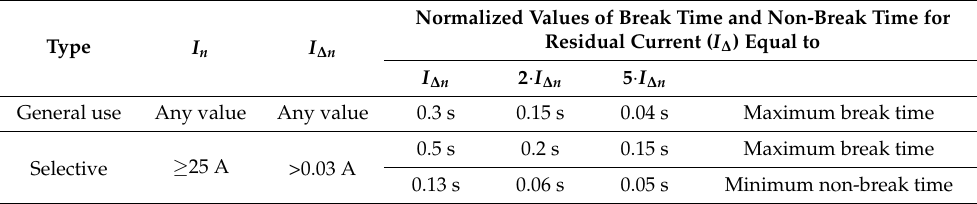
Table 1. Normalized values for RCD break time and non-break time